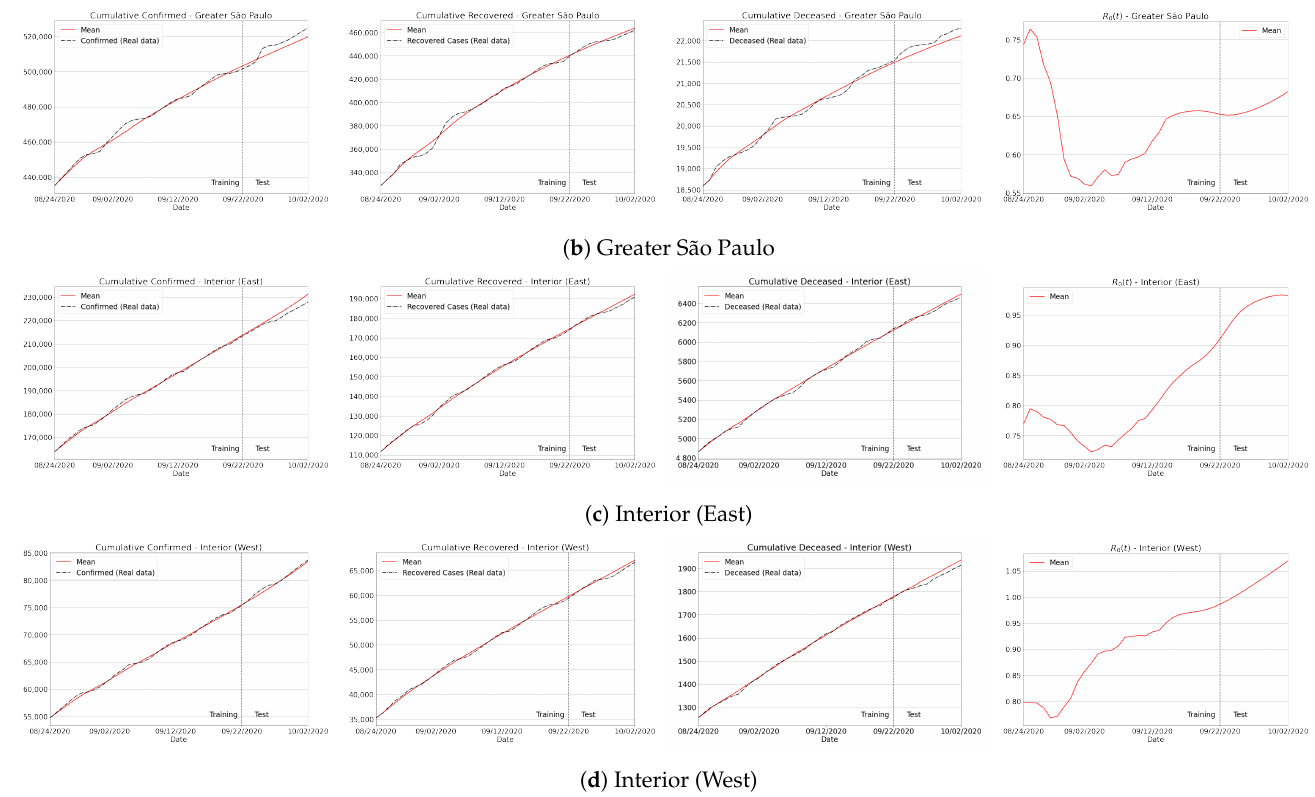
Figure A2. Forecasting results covering all the main regions of São Paulo.